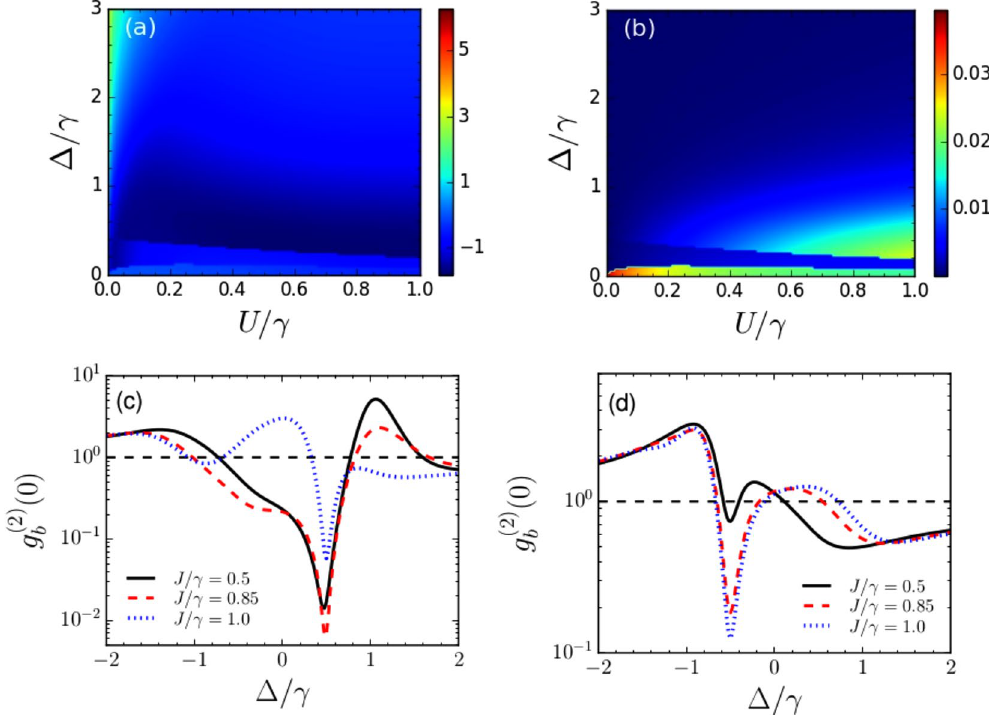
(2) as functions of normalized detuning Δ / γ and U / γ and ( b ) plot of Figure 5. ( a ) Logarithmic plot of g (0) b (2) for different values of J with phonon number in the primary resonator for ζ + , φ + . ( c ) Variation of g (0) b U opt = 0.5 γ and Δ opt = 0.5 γ . The black solid, red dashed and blue dotted lines correspond to J = 0.5 γ , 0.85 γ and γ , and the corresponding values of { ζ + , φ + / π } are {2.59, 0.20}, {1.60, 0.23} and {0.39, 0.06} respectively. ( d ) (2) for U = 0.5 γ and Δ = − 0.5 γ for J = 0.5 γ (black solid line), 0.85 γ (red dashed Shows the variation of g (0) opt opt b line) and γ (blue dotted line). The respective values of { ζ + , φ + / π } are {1.09, 0.88}, {0.82, 0.93} and {0.77, 0.95}. The dashed black lines correspond to = g